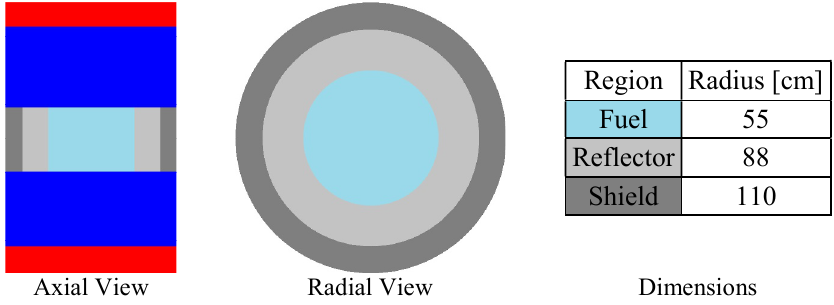
Figure 6. Geometry of Simplified Model for Radial